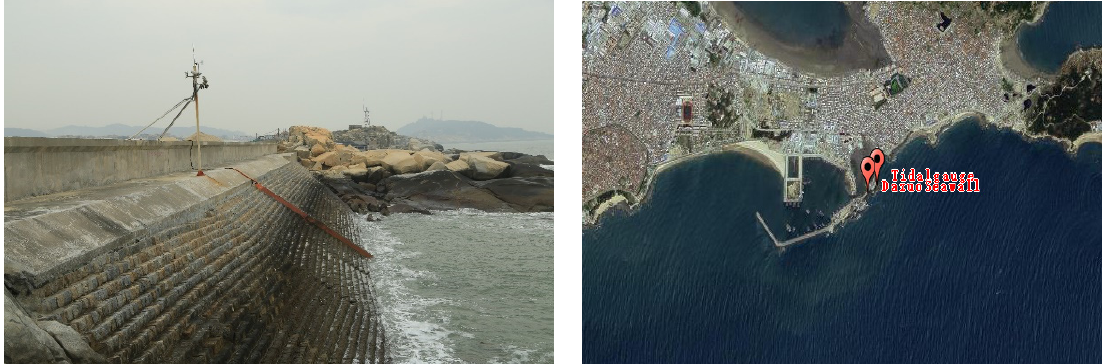
Figure 1. Location of Dazuo Seawall, the tidal gauge of